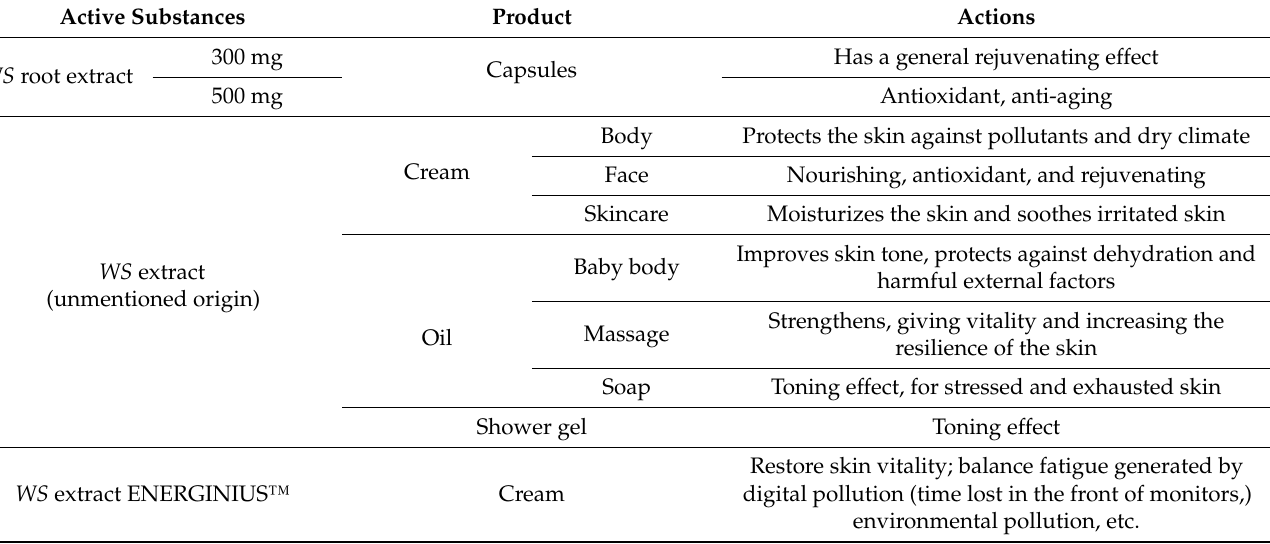
Table 1. Actions of the cosmetics and food supplements containing WS extracts on the skin